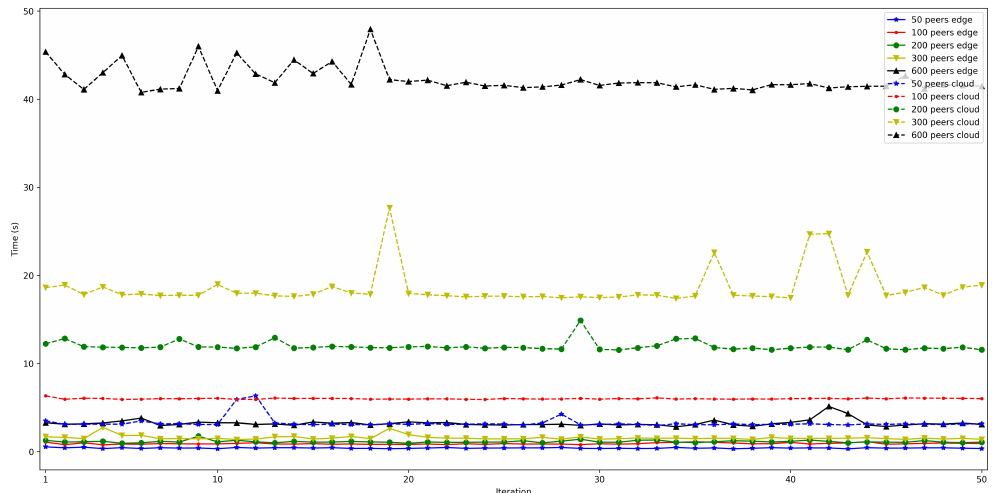
Figure 14. Put time when running the bootstrap node in the edge/cloud.